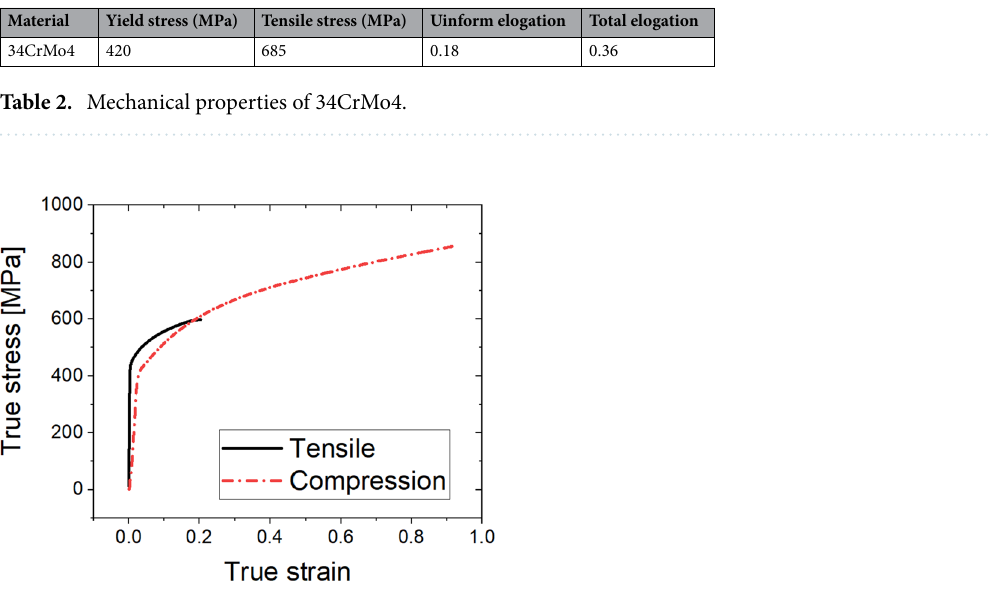
Figure 3. True stress–strain curve of